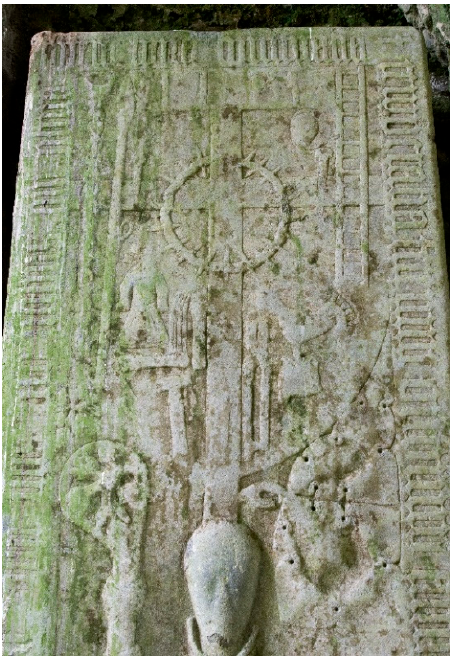
Figure 32. Tomb of abbot Philip O’Molwanayn, Kilcooley Abbey, Co. Tipperary, c.1463. Photograph by the author.